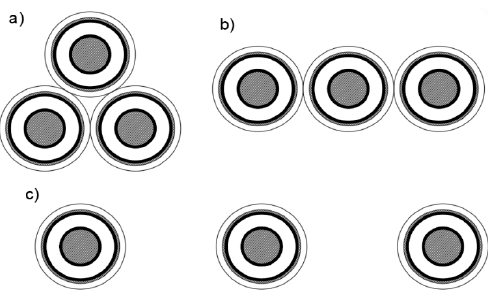
Figure 2. Cable formations: ( a ) trefoil, ( b ) flat, ( c ) flat, the distance between cables equal to one cable diameter (analyzed cable presented in right proportions).